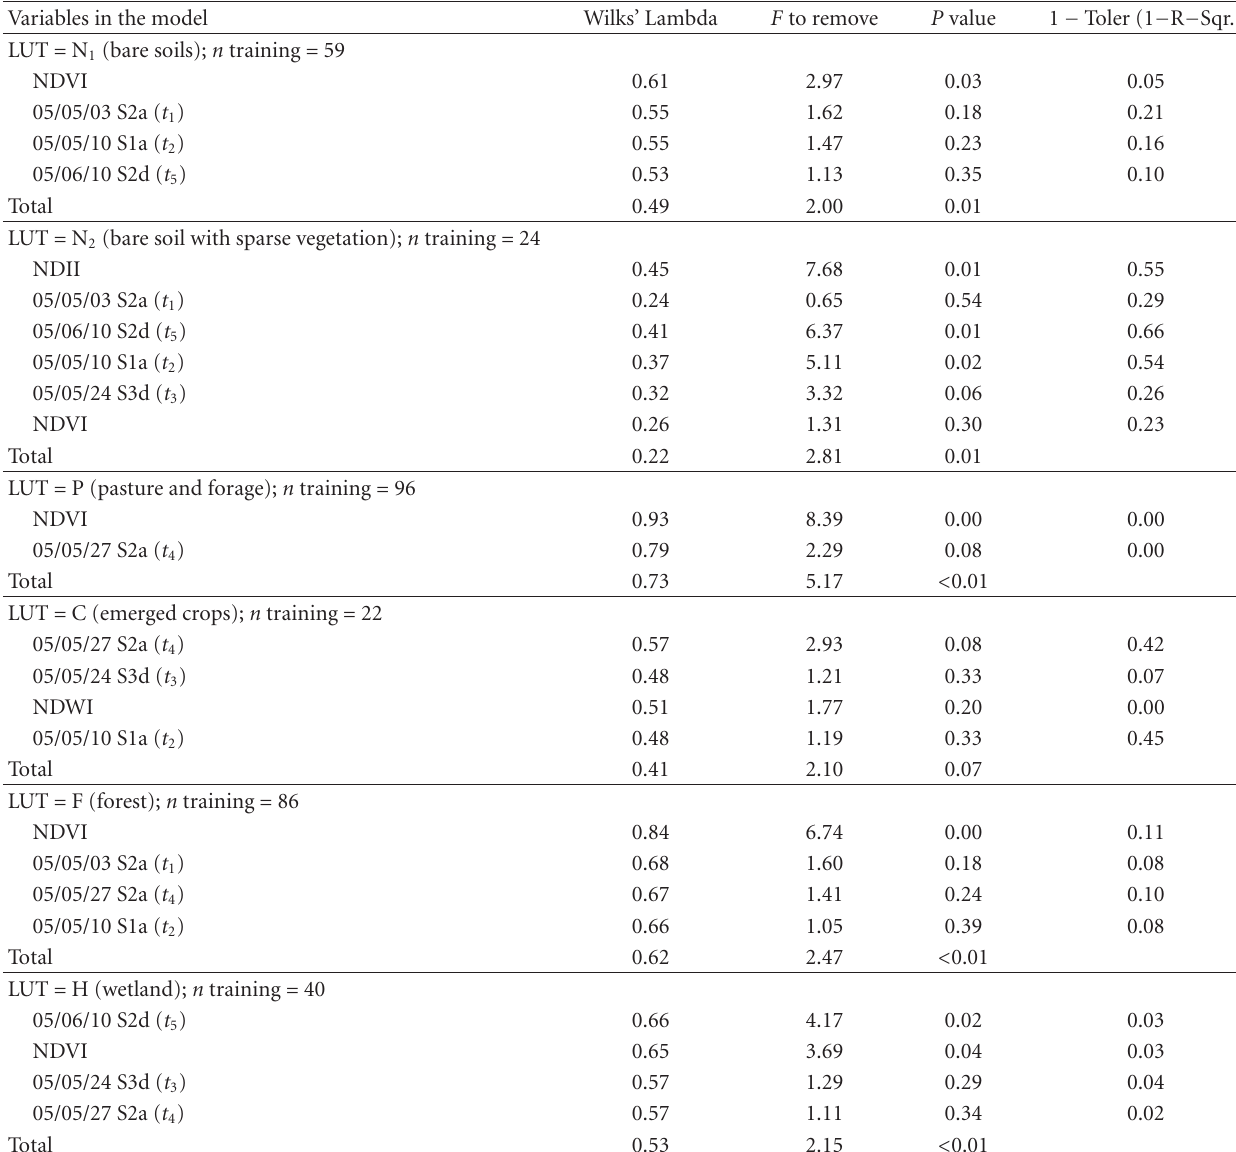
Table 6: Variables included in the drainage classification model using a forward stepwise discriminant analysis for di ff erent land use types (LUT).